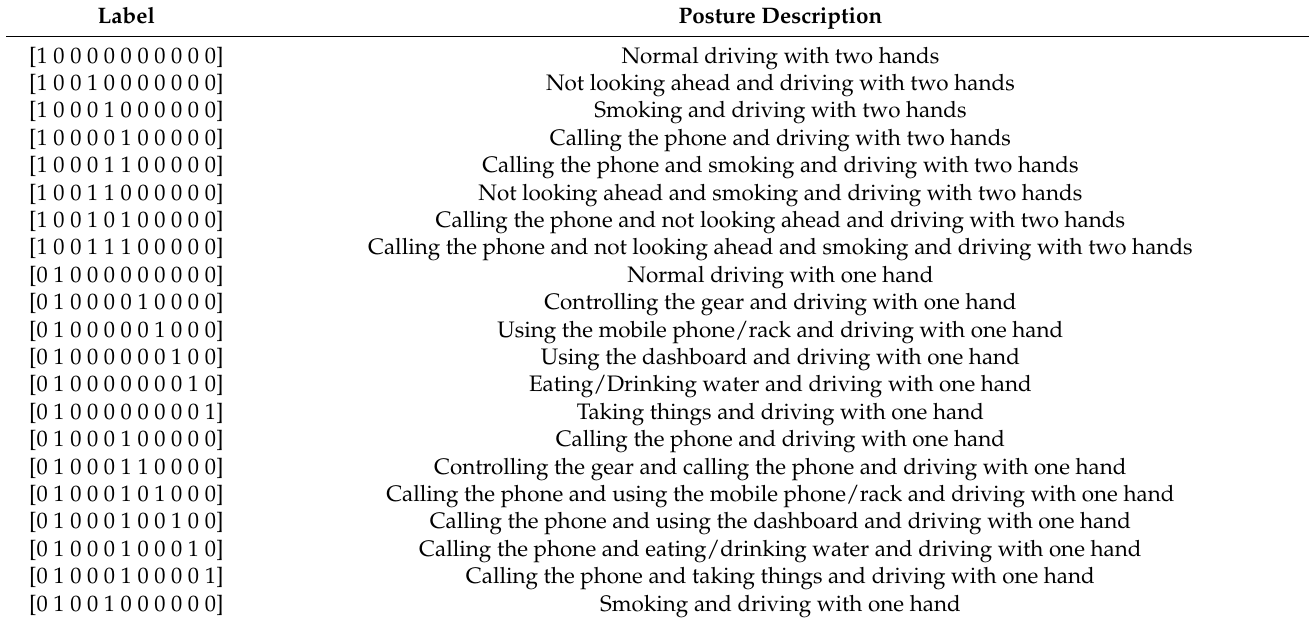
Table A1. Label set of driver’s posture.